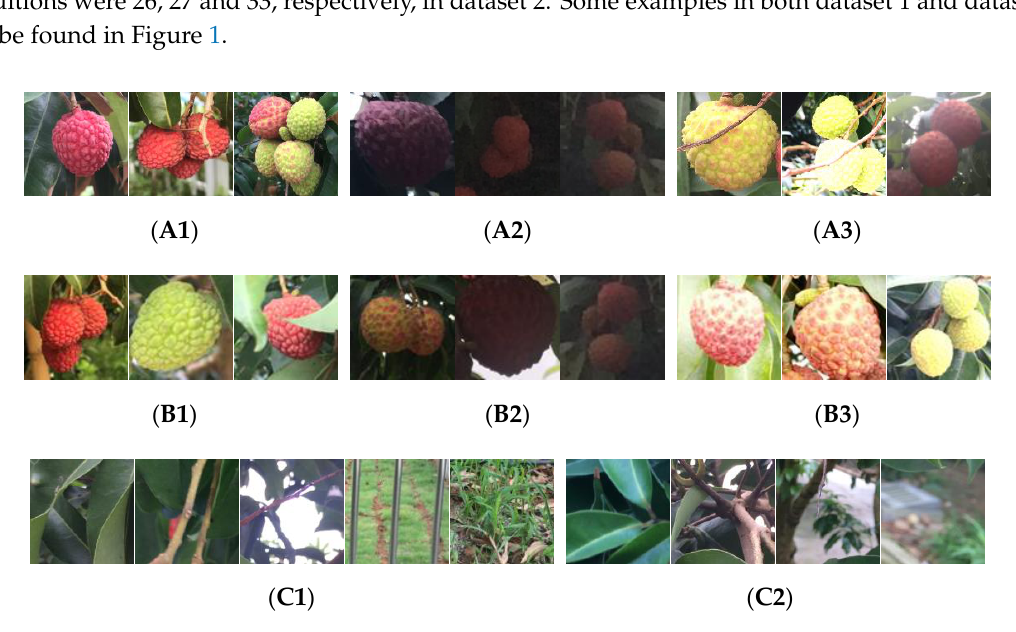
Figure 1. Examples of lychees in an orchard environment with a resolution of 100 × 100 pixels. ( A1 ) Well-illuminated examples of dataset 1. ( A2 ) Weakly illuminated examples of dataset 1. ( A3 ) Overexposure-illuminated examples of dataset 1. ( B1 ) Well-illuminated examples of dataset 2. ( B2 ) Weakly illuminated examples of dataset 2. ( B3 ) Overexposure-illuminated examples of dataset 2. ( C1 ) Non-lychee samples of dataset 1. ( C2 ) Non-lychee samples of dataset 2.